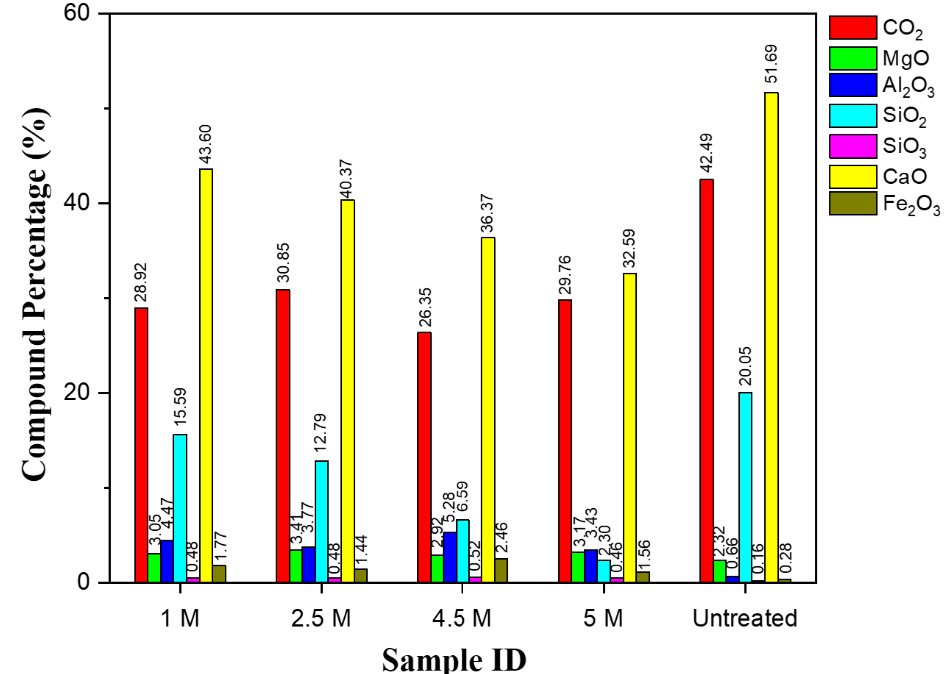
Figure 5. Compound composition of samples treated with H 2 SO 4 /untreated.